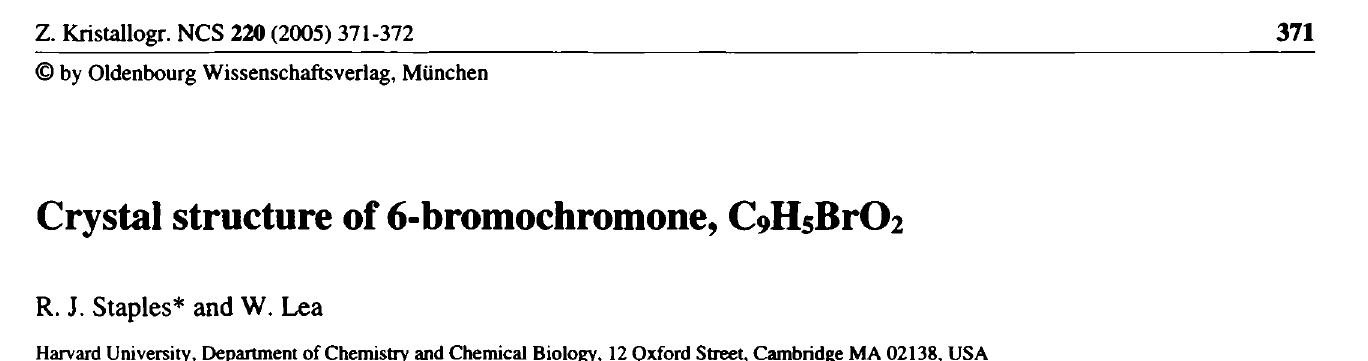
Table 1. Data collection and handling